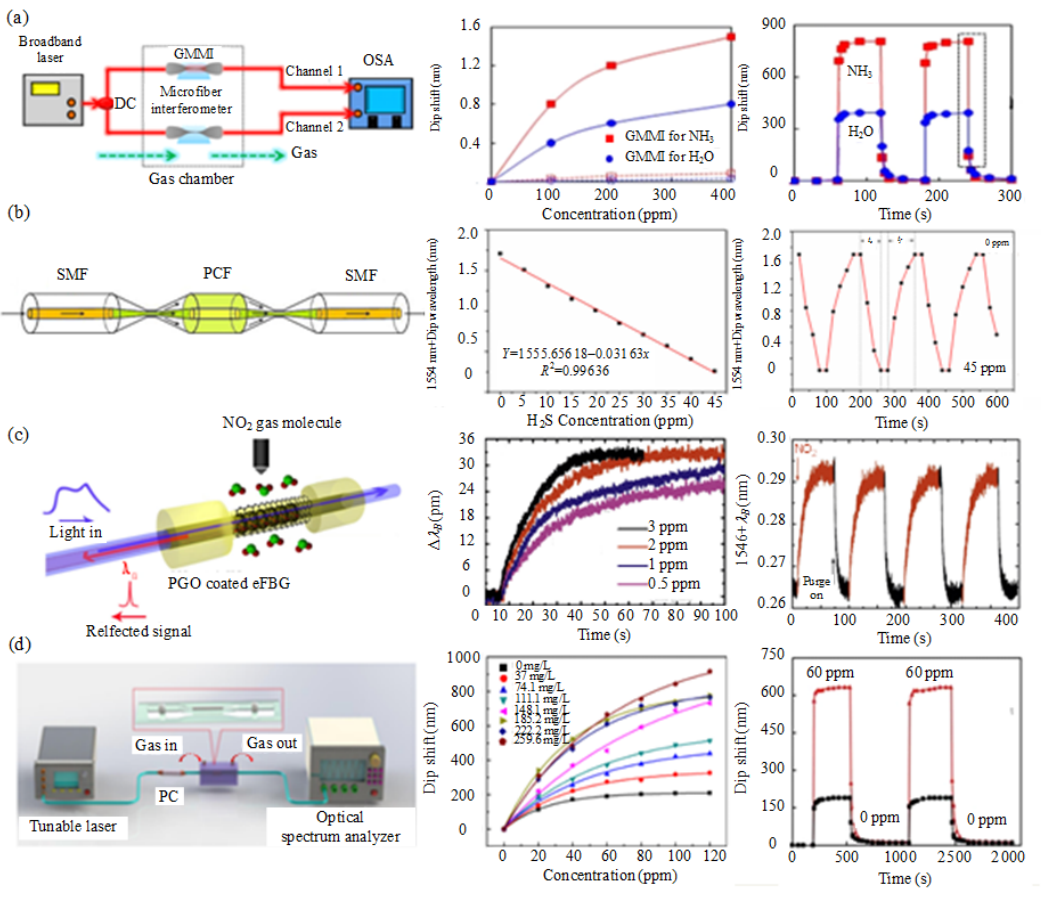
Fig. 4 Graphene-fiber gas sensors: (a) graphene/microfiber sensor for NH 3 and H 2 O [56], (b) graphene/PCF sensor for H 2 S [57], (c) rGO/etched FBG sensor for NO 2 [60], and (d) Pt nanoparticle-incorporated GO/microfiber sensor for NH 3